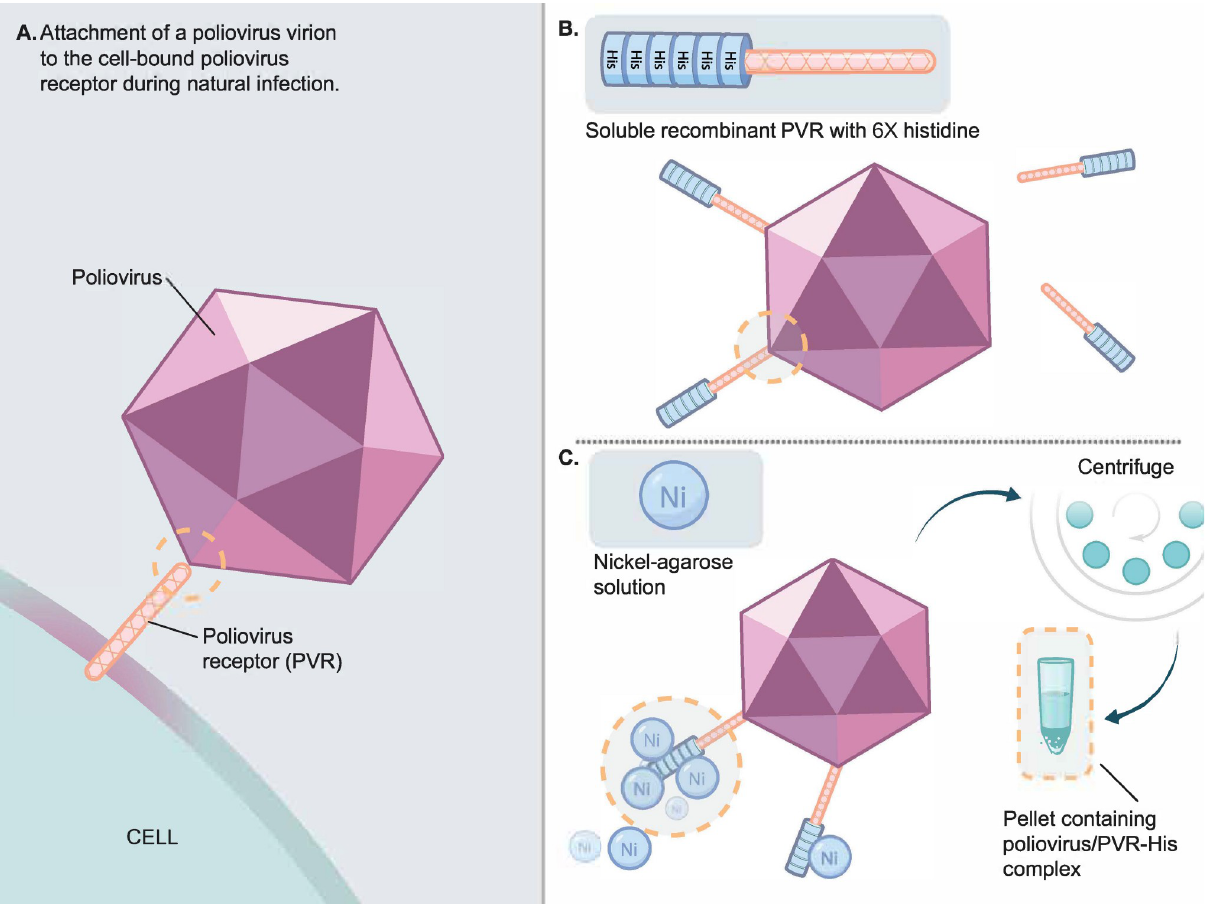
Fig 1. Schematic of poliovirus cellular attachment and the principle of soluble recombinant PVR-His enrichment. (A) Poliovirus attaches to cell bound PVR during natural infection. (B) Binding of soluble recombinant PVR-histidine and poliovirus. (C) Capture of PVR-histidine with nickel- agarose solution and pelleting of the PVR-His/poliovirus nickel agarose complex through centrifugation, removal of supernatant, and downstream application.